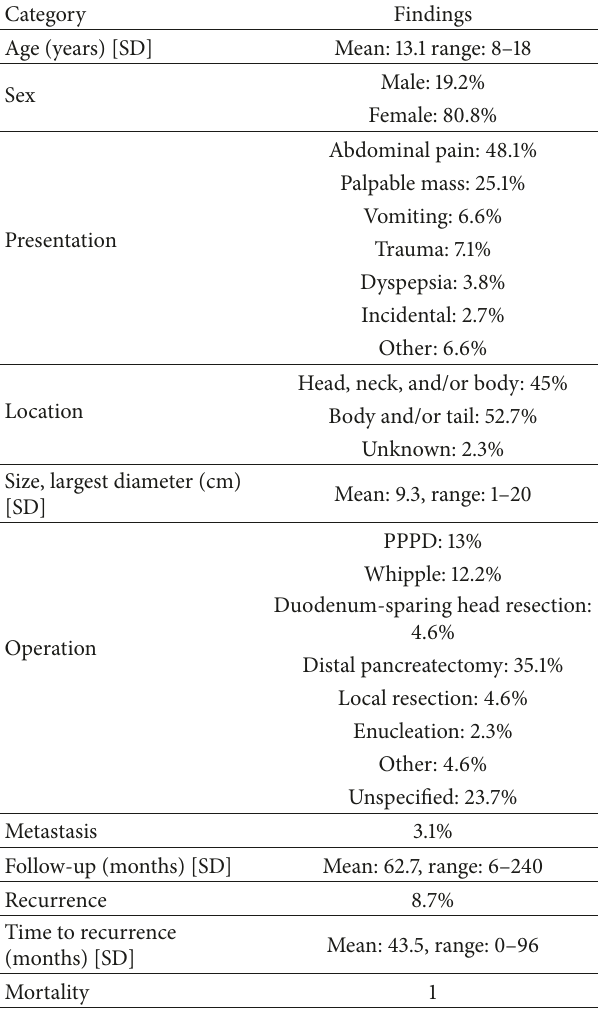
Table 1: Clinical data, ranging from 53 to 183 cases, of solid pseudopapillarytumourofthepancreasfromthepediatricliterature